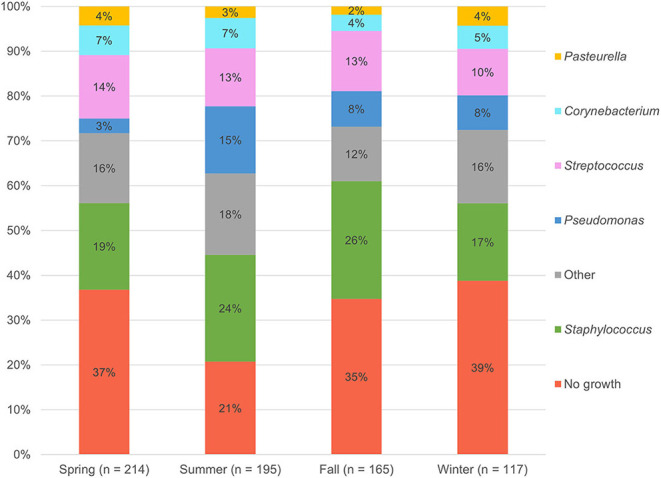
Percentage of bacterial genera isolated per season.